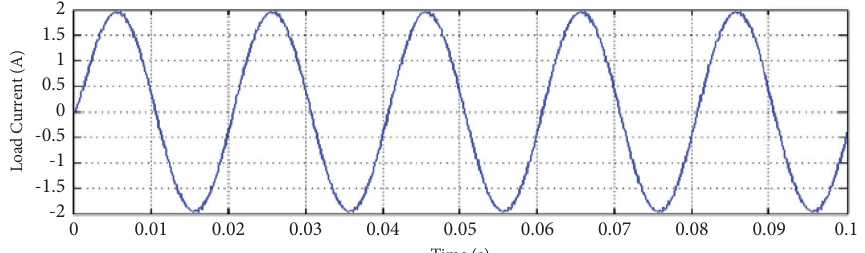
Figure 15: Inductive load current